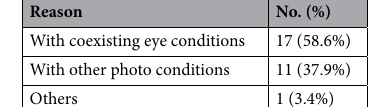
Table 3. The proportion of reasons for misclassification by the human